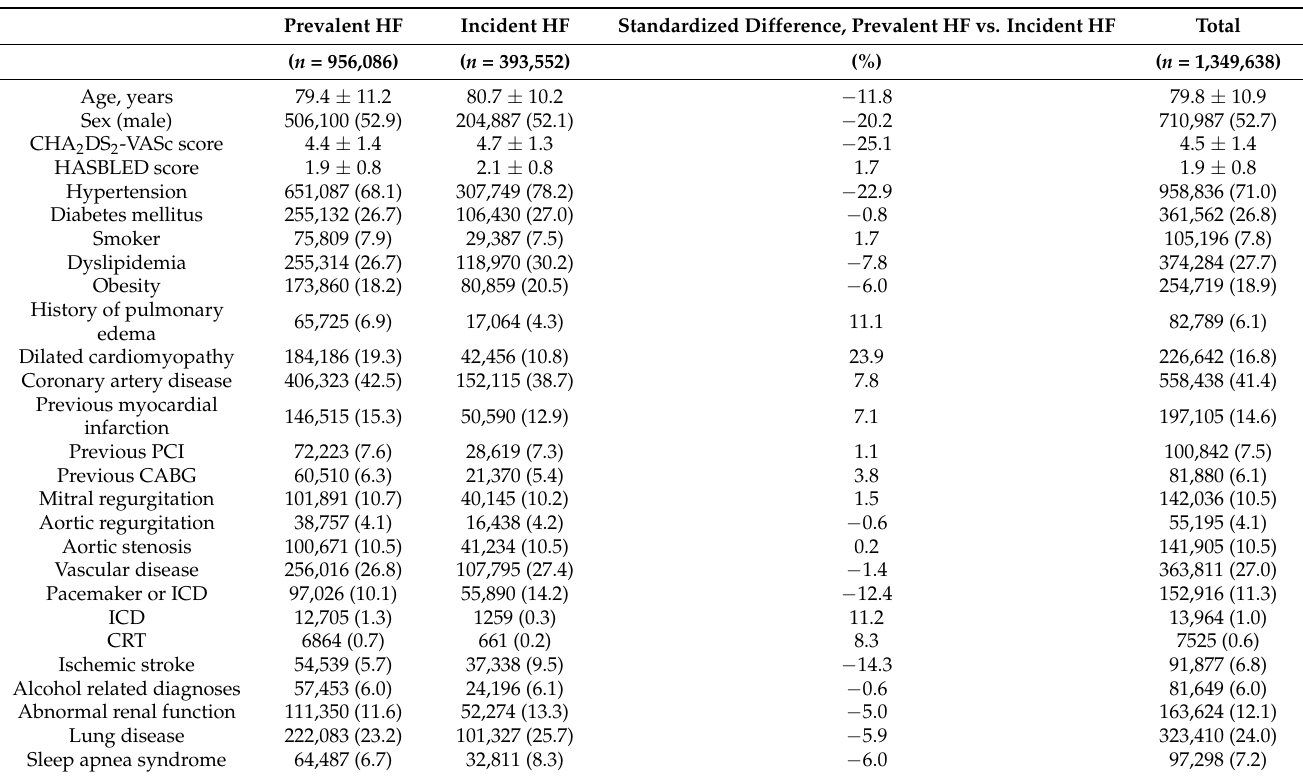
Figure 2. Standardized percentages of bias across main baseline characteristics in unmatched and matched patients with AF and HF, with incident HF and prevalent HF. Table 1. Baseline characteristics of unmatched patients with AF with prevalent HF or incident HF (follow-up starting at the time of last event between AF or